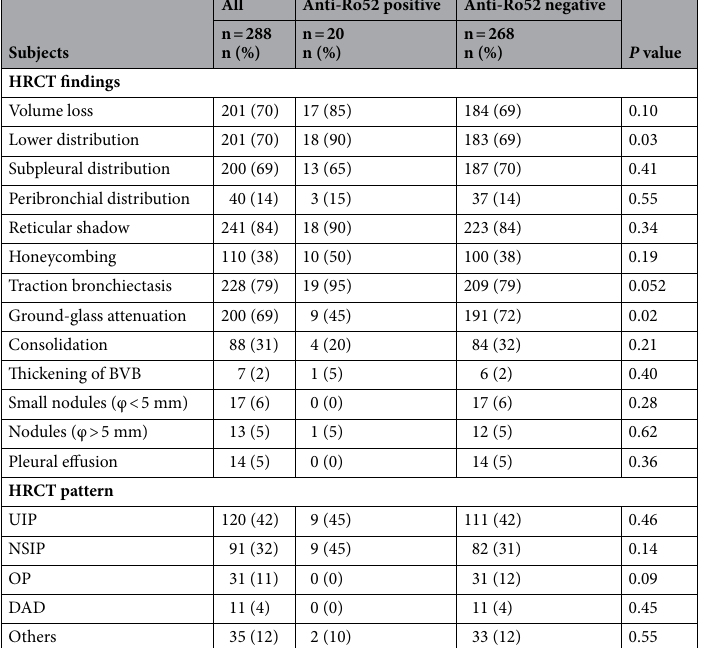
Table 5. Results and patterns of patients with/without anti-Ro52/tripartite motif-containing 21 antibodies (anti-Ro52). Data presented as frequencies (%). Ro52: Ro52/tripartite motif-containing 21; HRCT: high- resolution computed tomography; BVB: bronchovascular bundles; UIP: usual interstitial pneumonia; NSIP: nonspecific interstitial pneumonia; OP: organizing pneumonia; DAD: diffuse alveolar damage. P value: anti-Ro52 positive vs. anti-Ro52